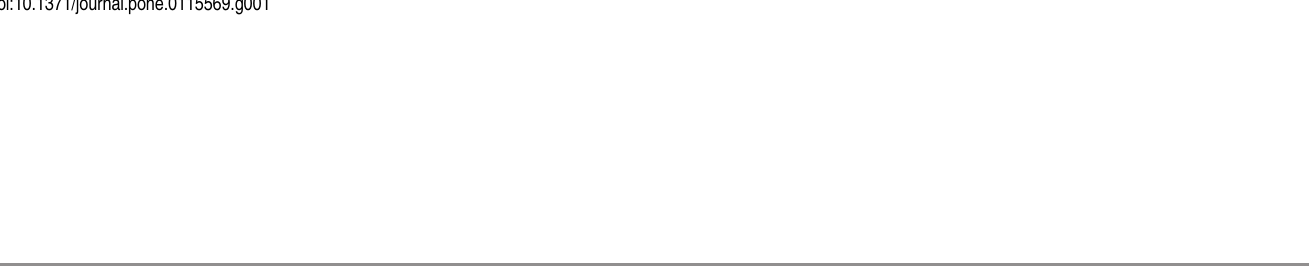
PLOS ONE | DOI:10.1371/journal.pone.0115569 December 31,